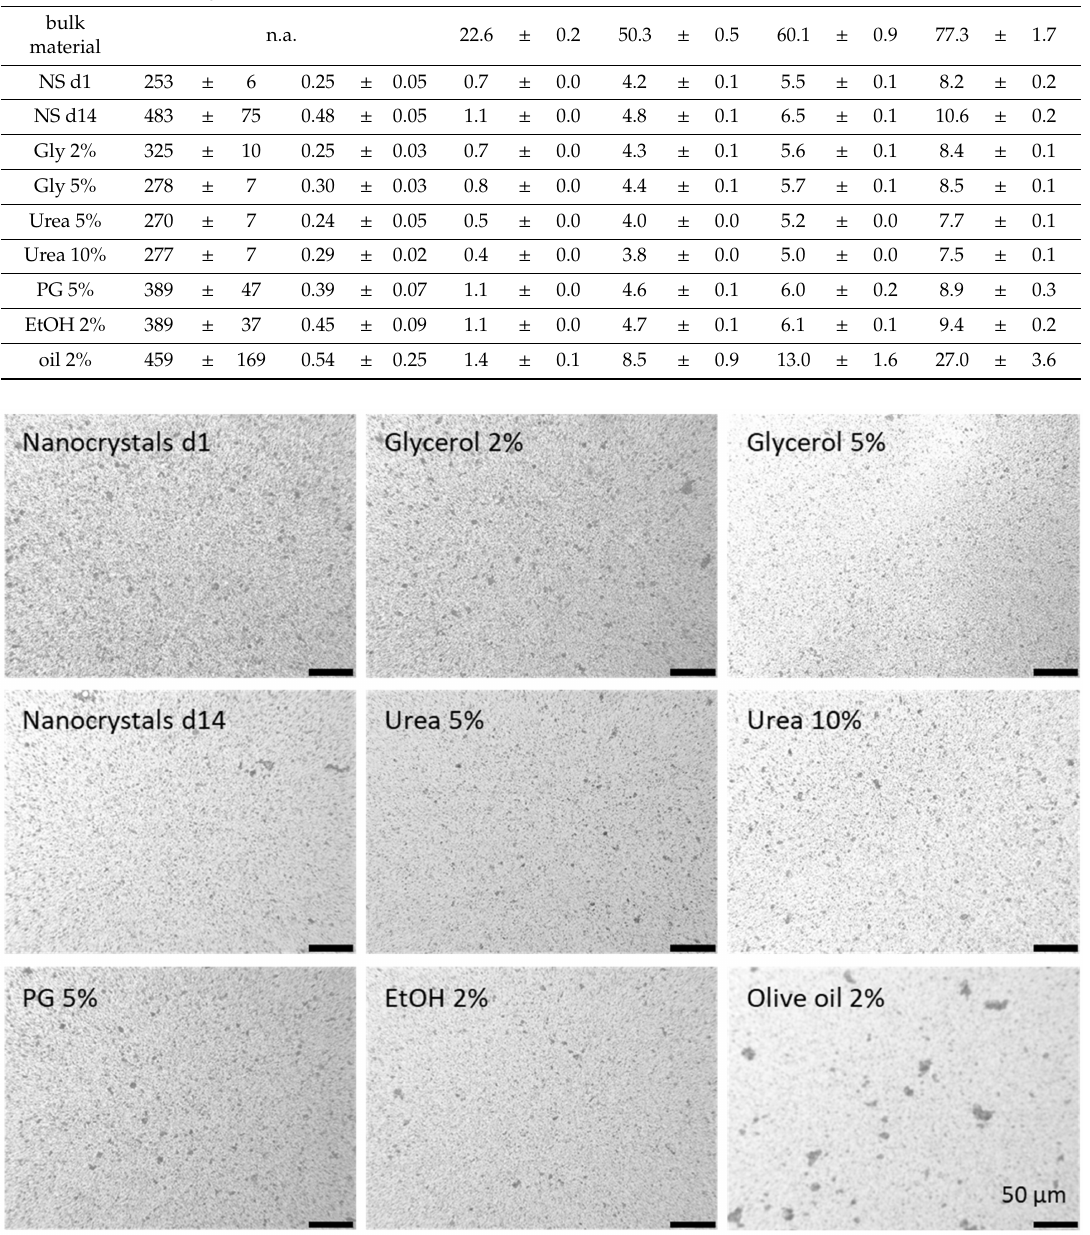
Figure 1. Microscopic images of the curcumin nanosuspension at the day of production, after 14 days of storage and after the addition of di ff erent excipients. Magnification: